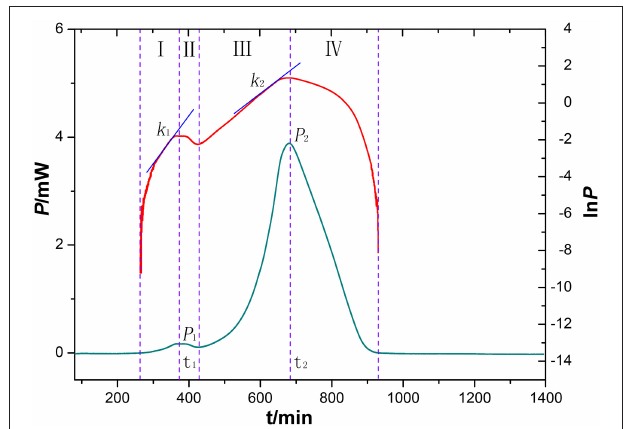
FIGURE 4 | HFP-time curves of P. aeruginosa growth without any extracts (blue), and the corresponding InP-time curve (red). The curves were divided into four phases (I-IV).The two curves reflect characteristic growth of P. aeruginosa at 37 ◦ C.